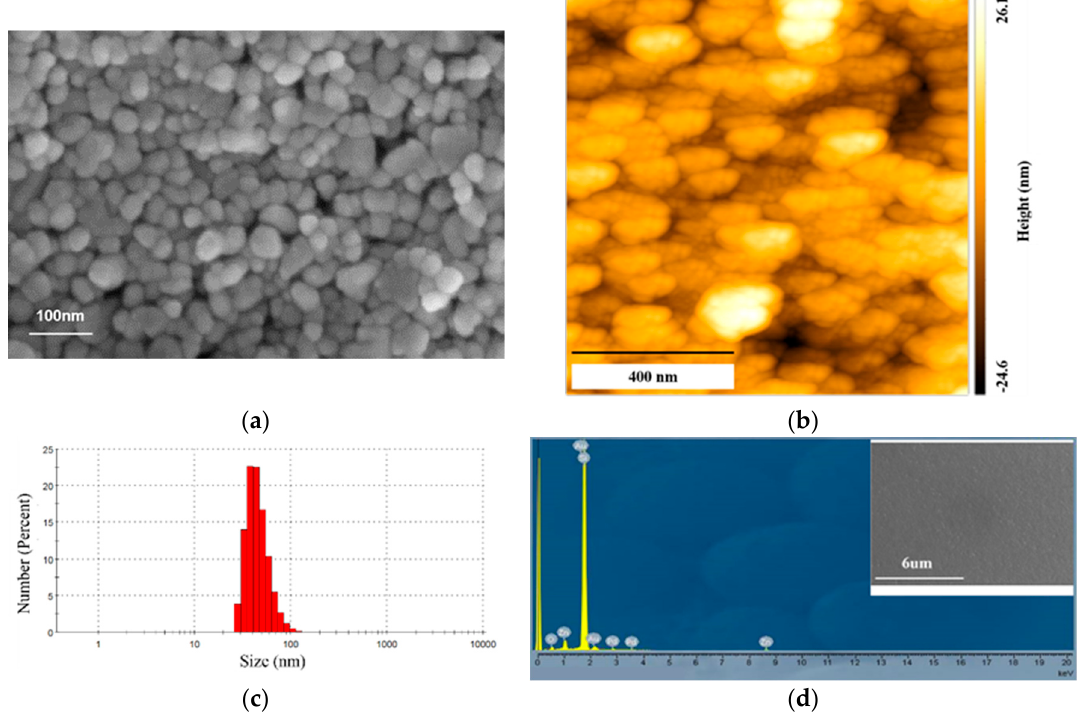
Figure 2. Image of ZnO NPs obtained by ( a ) a scanning electron microscopy and ( b ) an atomic force microscopy, ( c ) a size distribution, and ( d ) EDX spectrum of ZnO NP.